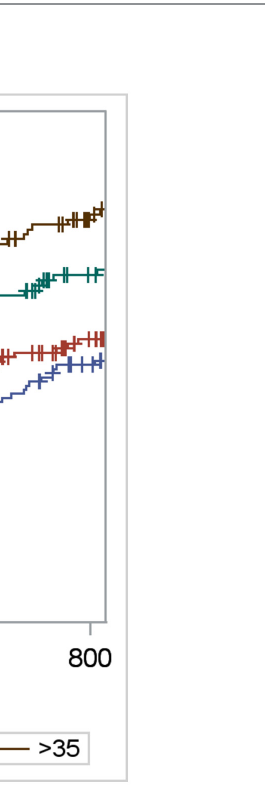
Fig 5. Cumulative verified enrollment in HIV care, by age group (years). Log-rank test for differences in functions = 18.39; P = 0.0004.